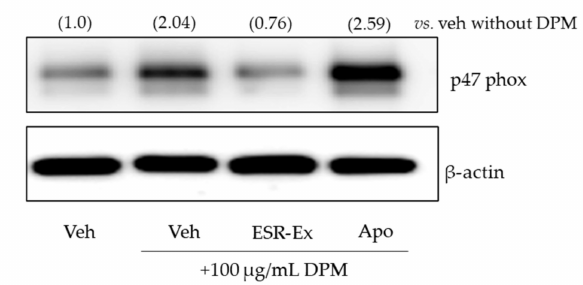
Figure 7. ESR-Ex suppresses increases in p47phox in KC exposed to DPM. KC were incubated with or without ESR-Ex (100 µ g/mL), Apo (100 µ M) or vehicle for 30 min, and then further cultured with 100 µ g/mL of DPM for 24 h. p47phox and β -actin were analyzed by Western blot. Fold changes compared with the vehicle without DPM are shown in parentheses. See details in Materials and Methods